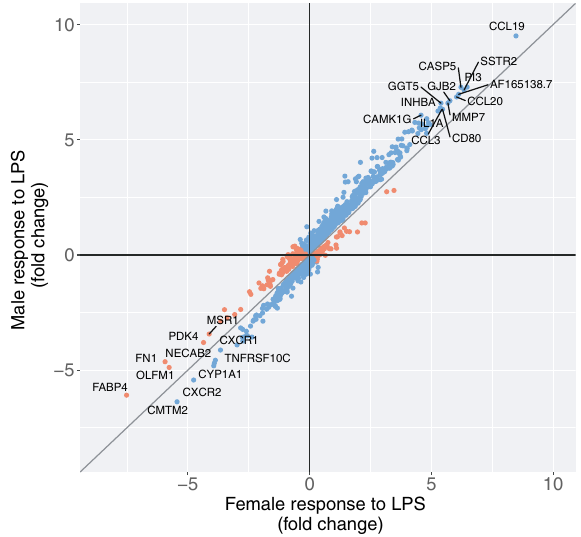
Figure 4. Scatterplot of fold change for genes with significant (FDR < 0.05) sex by LPS treatment interaction effects (n = 1055). Genes colored in blue have a larger absolute magnitude of response to LPS in males compared to females; genes colored orange have a larger absolute magnitude of response in females compared to males. Labeled genes have a fold change of > 6 or < − 4.